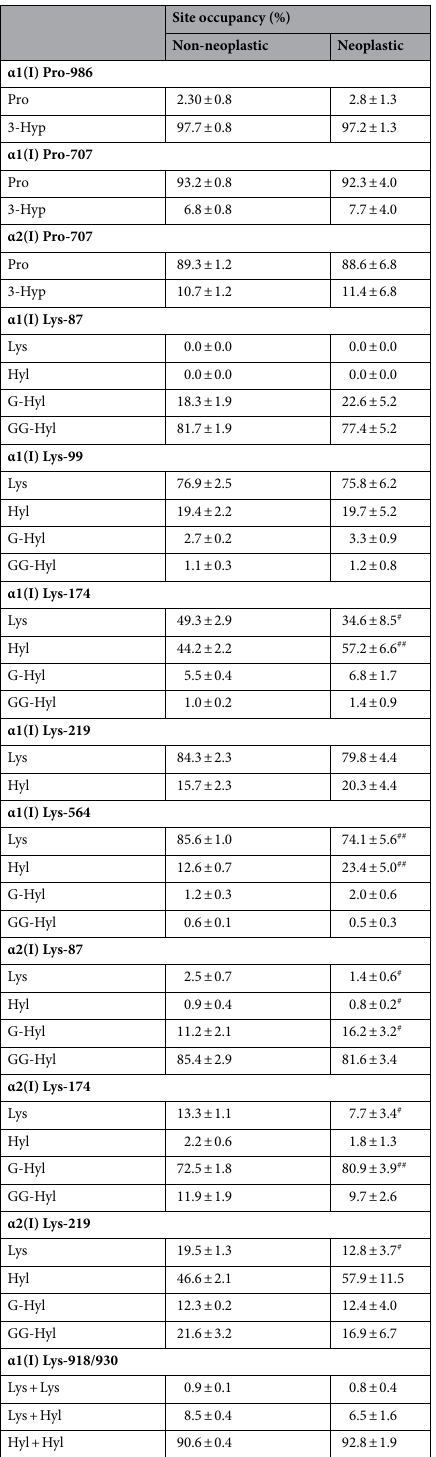
Table 2. Summary of site-specific modification analysis by mass spectrometry of non-cross-linked, hydroxylated and glycosylated residues in the triple helical domain of type I collagen from canine non-neoplastic and neoplastic mammary tissue samples. Lys hydroxylation and its glycosylation (%) represents the relative levels of Lys, Hyl, G-Hyl, and GG-Hyl (Lys + Hyl + G-Hyl + GG-Hyl = 100%), and Pro 3-hydroxylation represents the relative levels of Pro and 3-Hyp (Pro + 3-Hyp = 100%). Pro, proline; 3-Hyp, 3-hydroxyproline; Lys, lysine; Hyl, hydroxylysine; G-, galactosyl-; GG-, glucosylgalactosyl. Values represent mean percentages ± S.D. (non-neoplastic, n = 3; neoplastic, n = 9). # p < 0.05, ## p < 0.01 between non-neoplastic and neoplastic via unpaired Student’s